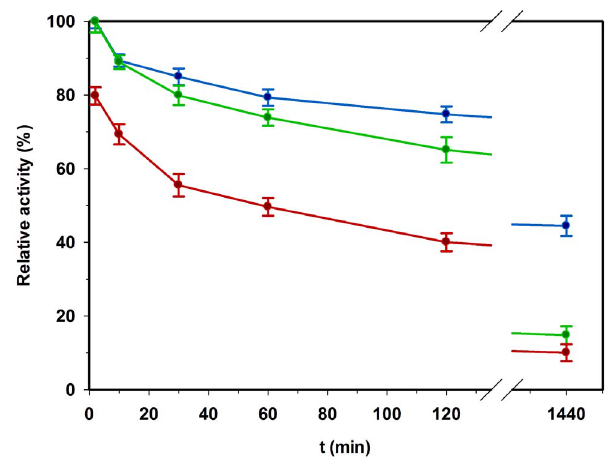
Figure 7. Time course of Ta AlDH deactivation by organic solvent and its reactivation. Deactivation of refolded Ta AlDH was measured after incubation for indicated time at 50 u C in 3% v/v isobutanol (red) or 0.3% v/v isobutanol (blue). Furthermore, samples incubated in 3% v/v isobutanol were also measured after 10-fold dilution to 0.3% v/v isobutanol (green) to test reactivation within 2 min.